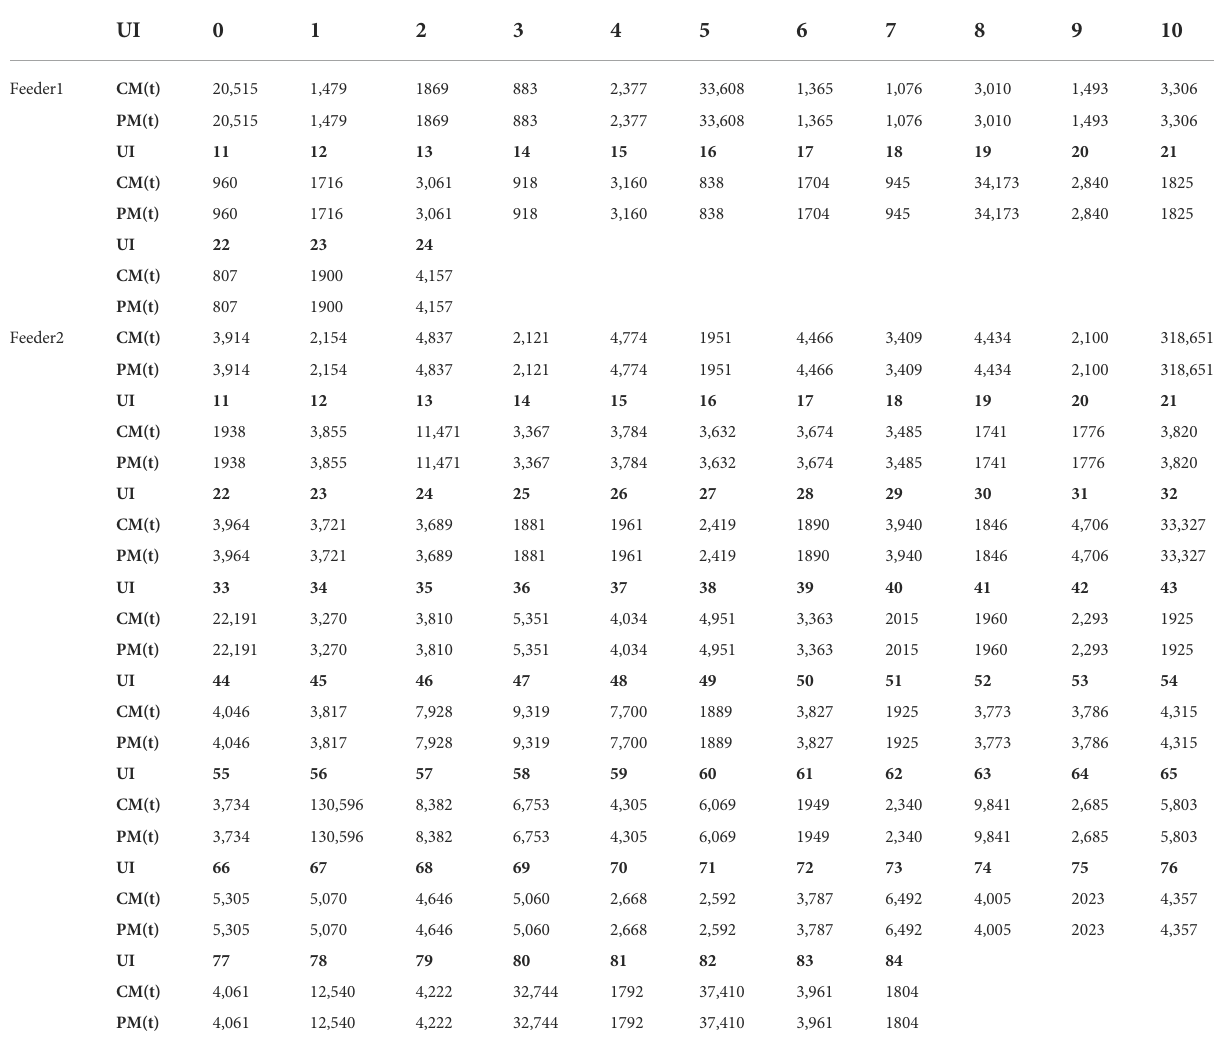
TABLE 1 Monthly carbon emission calculated by TM and PM.